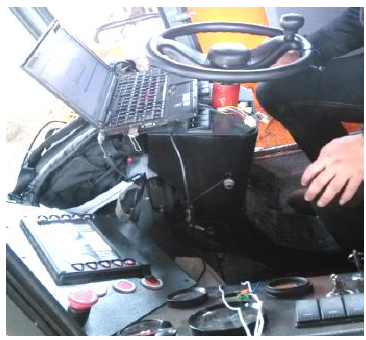
Figure 15. Data measuring in the field.